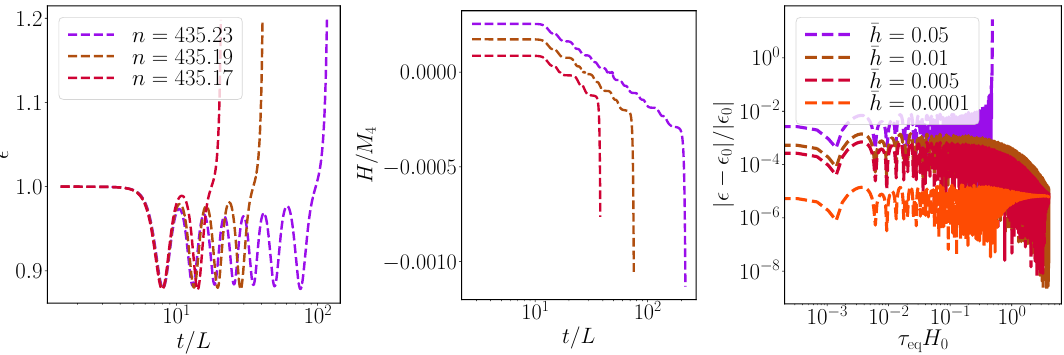
Figure 10 . The aspect ratio (left) and effective Hubble rate (middle) for a few initially spherical solutions with n < n . The relative difference in the aspect ratio from the background value for a I sample solution on the small Hubble warped branch with p = q = 4 , Λ and successively larger ‘ = 2 perturbations